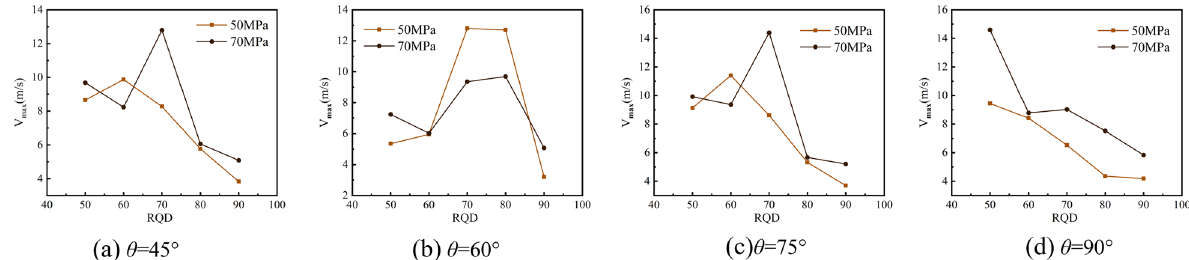
Fig. 32 V max with different RQD and in-situ stress values in the same